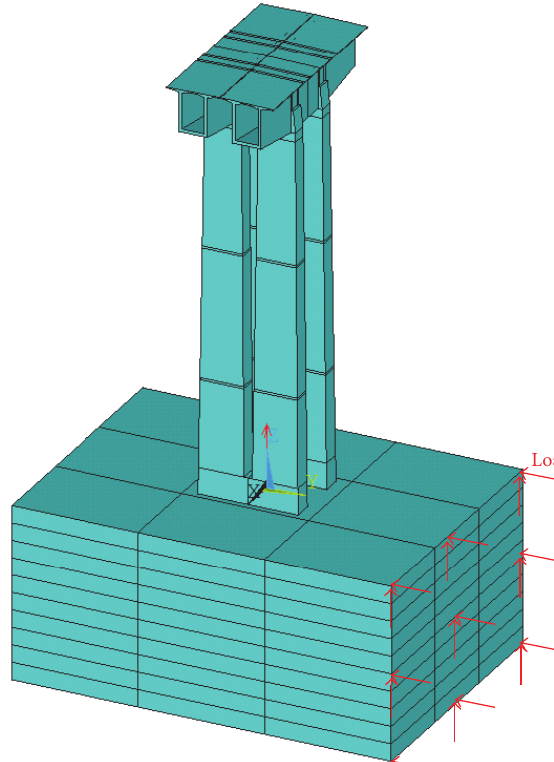
Figure 7: Finite element model (model